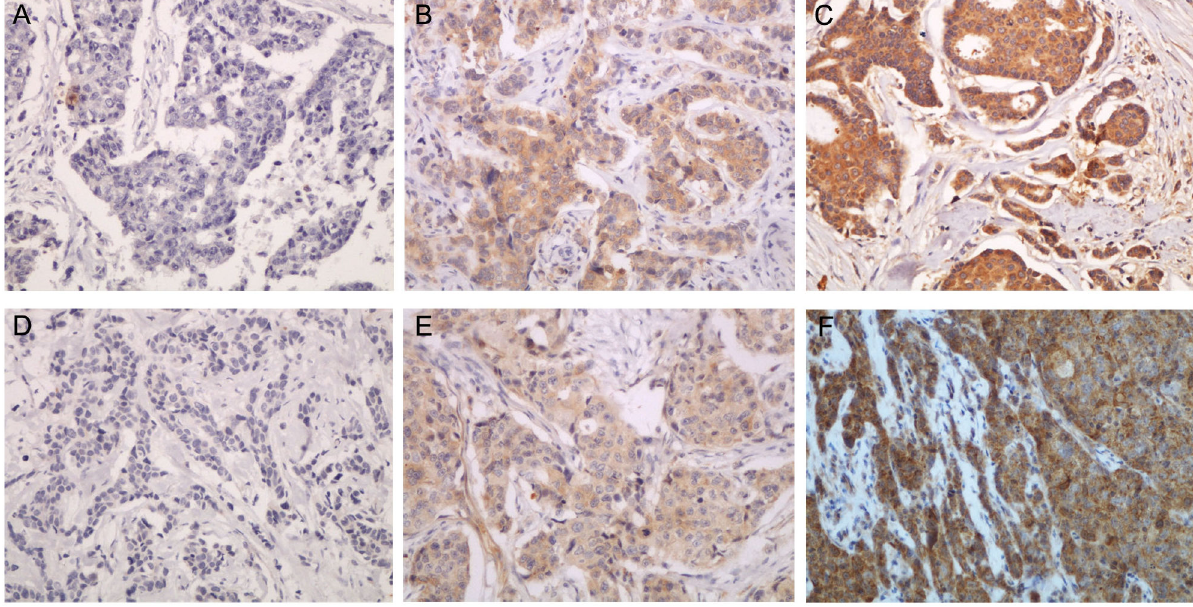
Figure 1. CCL22 and TGF-β1 expression in BC. (A) Negative expression of TGF-β1 in BC (×200). (B) Weak expression of TGF- β1 in BC (×200). (C) Strong expression of TGF-β1 in BC (×200). (D) Negative expression of CCL22 in BC (×200). (E) Weak expression of CCL22 in BC (×200). (F) Strong expression of CCL22 in BC (×200).